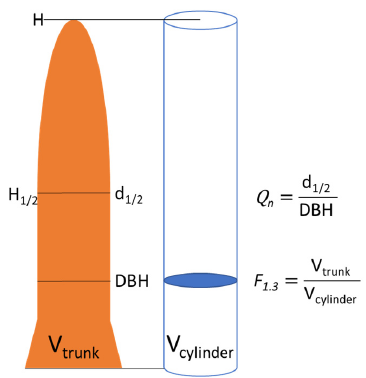
Figure 1. Calculation of breast height form factor ( F 1.3 ), and normal form quotient ( Q n ), where V trunk is the trunk volume; V cylinder is the volume of a cylinder with a diameter at 1.3 m of the tree height; DBH is the diameter at breast height; d 1/2 is the diameter at 1/2 the height of the tree; H is the tree height; and H 1/2 is the position at 1/2 the height of the tree.